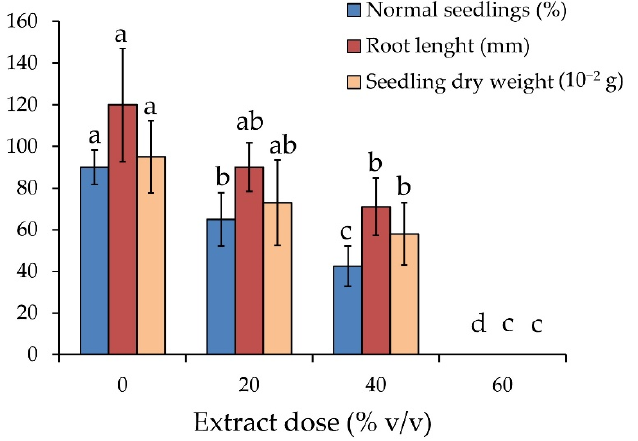
Figure 4. Effects of increasing doses (% volume/volume, v / v ) of the giant reed extract on the germination of zucchini seeds, on filter paper, measured as a percentage of normal seedling, rootlet length, and total dry weight. Means labelled with the same letter within the same parameter did not differ for p ≤ 0.05 (Tukey’s test after one-way ANOVA). Bars represent standard deviation values.